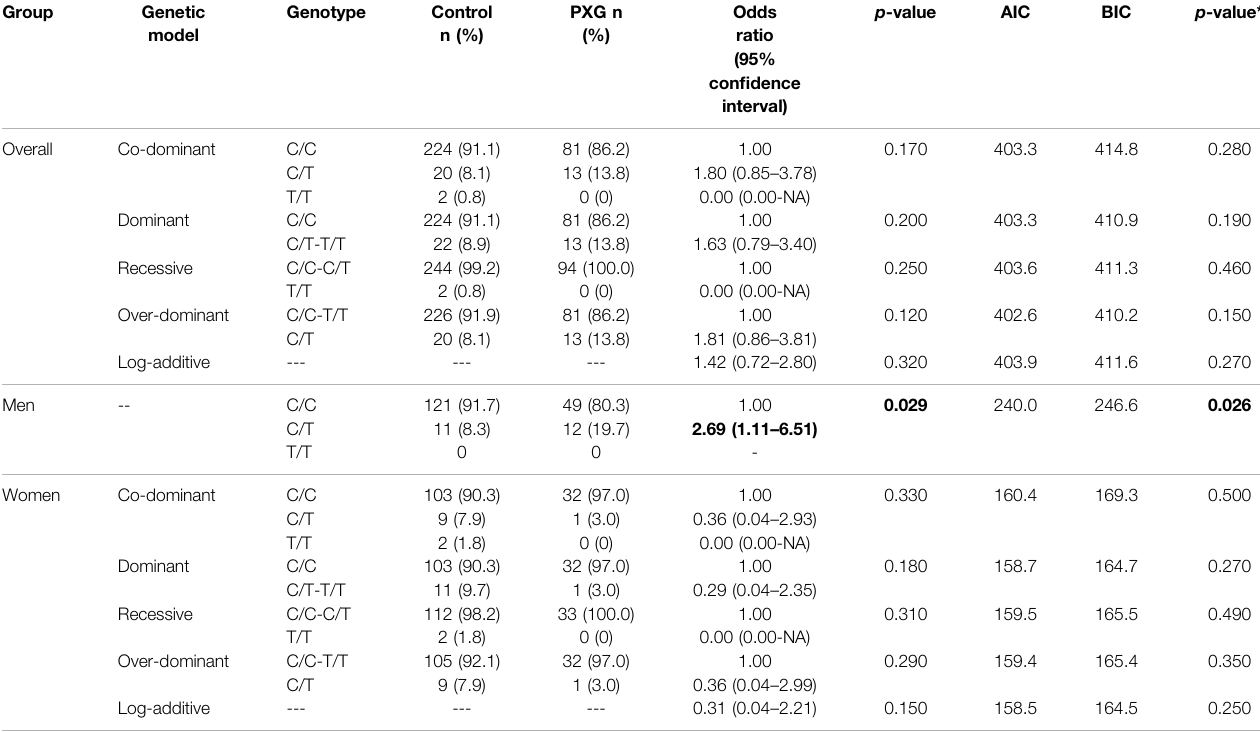
TABLE 4 | Genotype association analysis of rs7636836 variant in FNDC3B in pseudoexfoliation glaucoma. Group Genetic